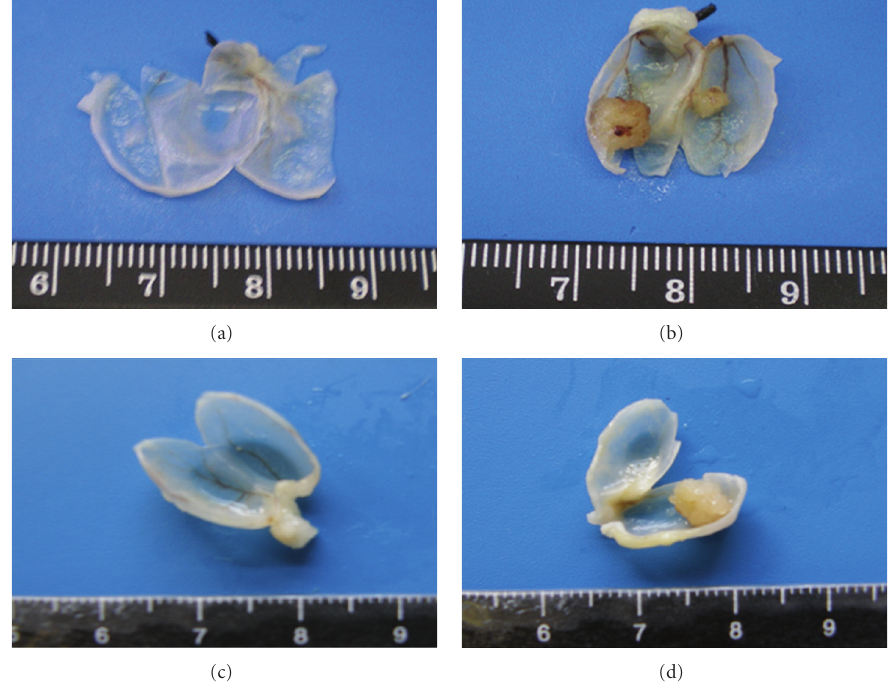
Figure 1: Macroscopic histomorphological evaluation of bladders. All the bladders from the control (a) and CEL (data not shown) treated rats have revealed a pattern of normality, with absence of any type of malignity. In the BBN group (b), 65.0% of the rats had bladder tumors, almost all easily seen by macroscopic analysis. The bladder walls were thicker, with new or enlarged small vessels, suggesting neo-angiogenesis, and there was unequivocal formation of tumor (some bladder presented more than one tumor). In the preventive CEL (CEL+BBN-P group) treatment (c), except in one case, all bladders shows a similar pattern to those seen for the control or CEL rats, with macroscopically unrecognized signs of abnormality. However, in the curative CEL (BBN+CEL-C group) use (d), there was 75% of tumor incidence, with even more malignant neoplasic